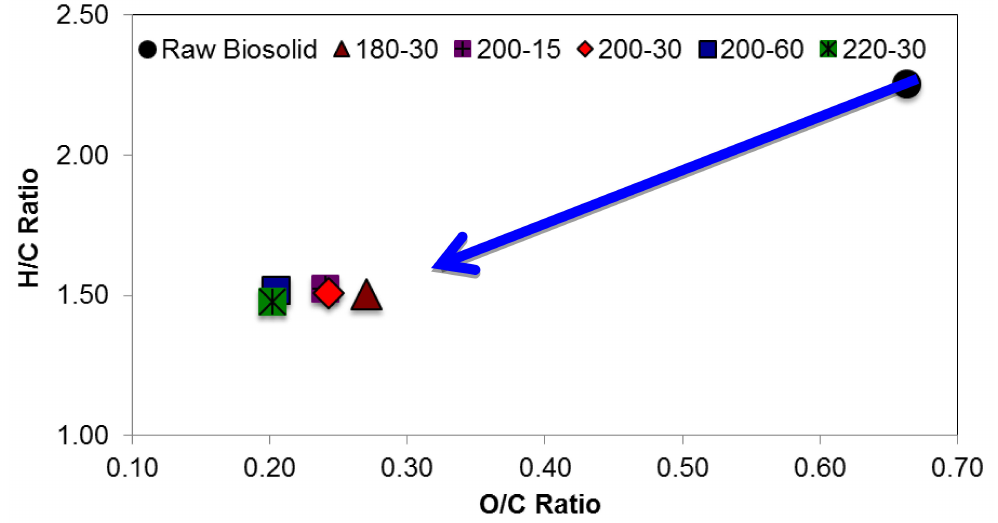
Figure 3. Van Krevelen diagram for raw and solid